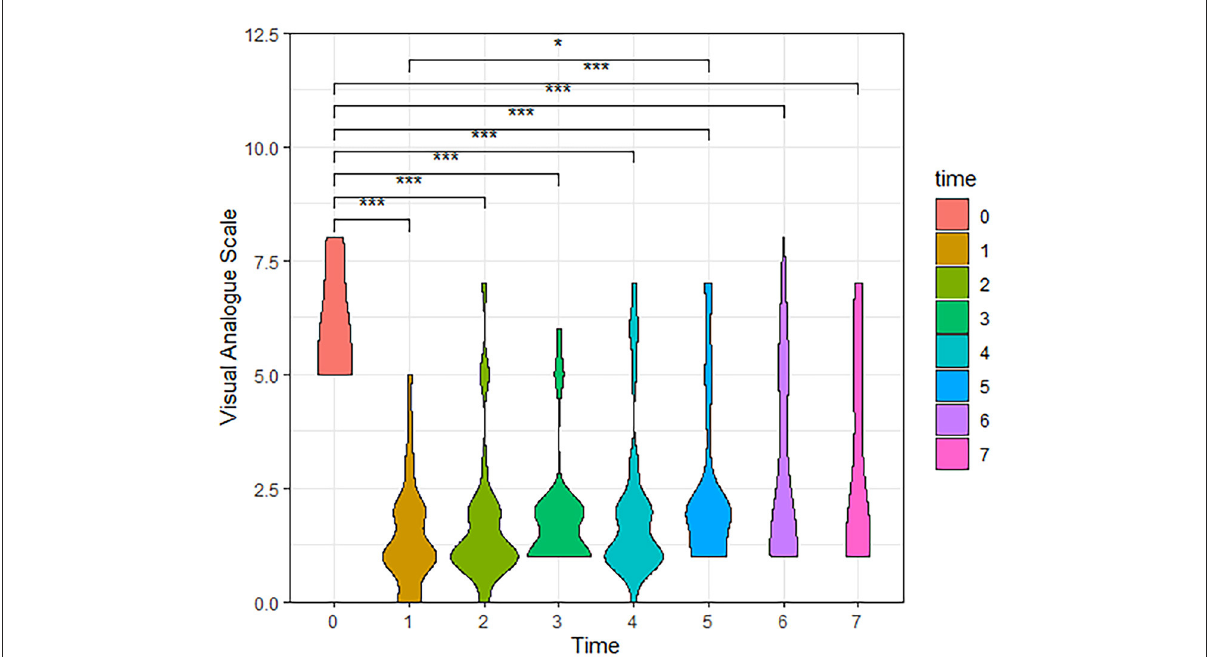
FIGURE4 The Violin Plot of Visual Analog Scale (VAS) scores based on 28 patients followed up to 3 years postoperatively. Compared with the preoperative, patients had significantly lower VAS scores at all postoperative time periods. (t0, Pre-operation; t1, Post-operation; t2, One month; t3, Three months; t4, Six months; t5, One year; t6, Two years; t7, Three years, *** P < 0.001, * P < 0.05).